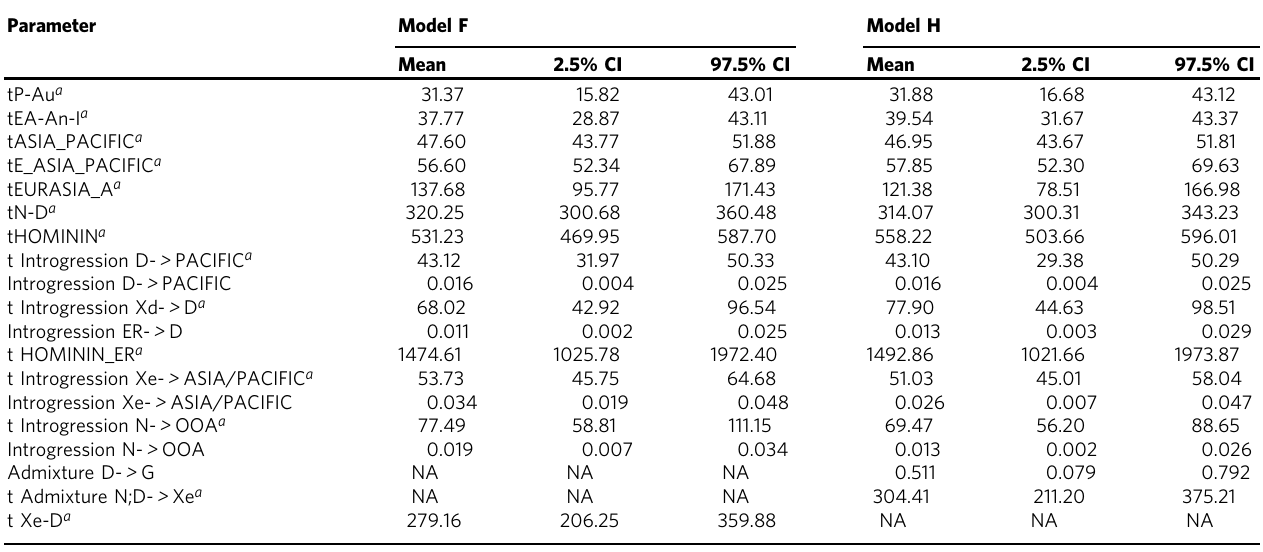
The parameters were estimated by means of ABC-DL NA Not Applicable, P Papua, Au Australia, EA East Asia, An Andaman, I India, A Africa, D Denisova, N Altai Neanderthal, t time a Kya assuming a generation time of 29 years